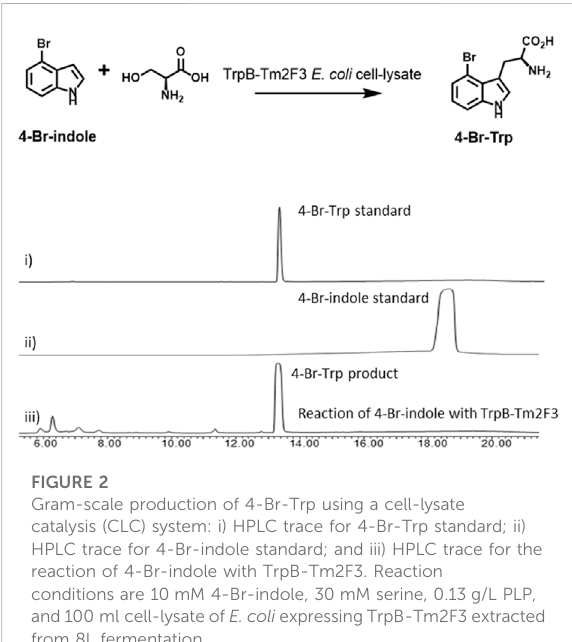
FIGURE 2 Gram-scale production of 4-Br-Trp using a cell-lysate catalysis (CLC) system: i) HPLC trace for 4-Br-Trp standard; ii) HPLC trace for 4-Br-indole standard; and iii) HPLC trace for the reaction of 4-Br-indole with TrpB-Tm2F3. Reaction conditions are 10 mM 4-Br-indole, 30 mM serine, 0.13 g/L